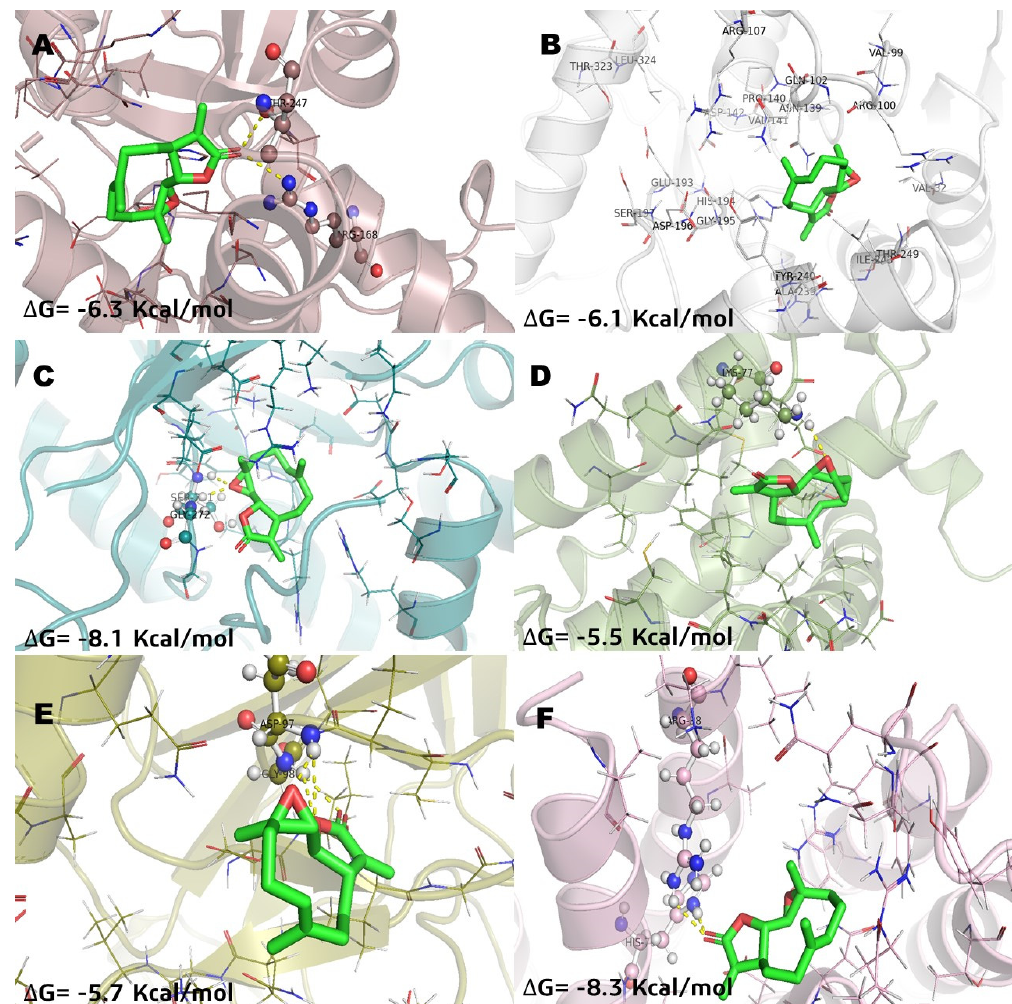
Figure 3. Molecular model of virtual screening for parthenolide ( Pa ) bound to ( A ) L-lactate dehydrogease A chain (LHDA), ( B ) L-lactate dehydrogenase B chain (LDHB), ( C ) Fructose-bisphosphate aldolase (ALDOA), ( D ) Bcl-2-regulator protein A1 (BCL-2A1), ( E ) NF-kappa B p65 (RelA) homodimer (NFkB), and ( F ) Microsomal glutathione S-transferase 1 (MGST1); Δ G = binding energy.